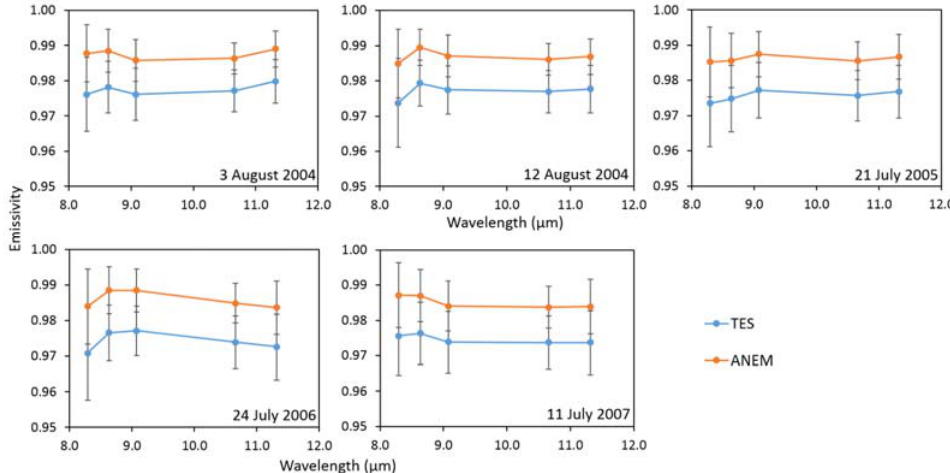
Figure 6. Mean emissivity retrieved with TES and ANEM methods using the pixels classified as rice crop for the five thermal ASTER bands.